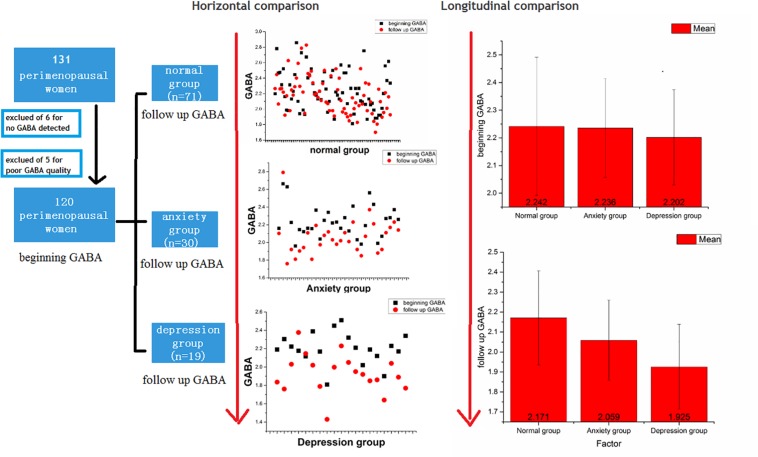
Flow chart and comparisons of GABA levels between the normal, anxiety, and depression groups.